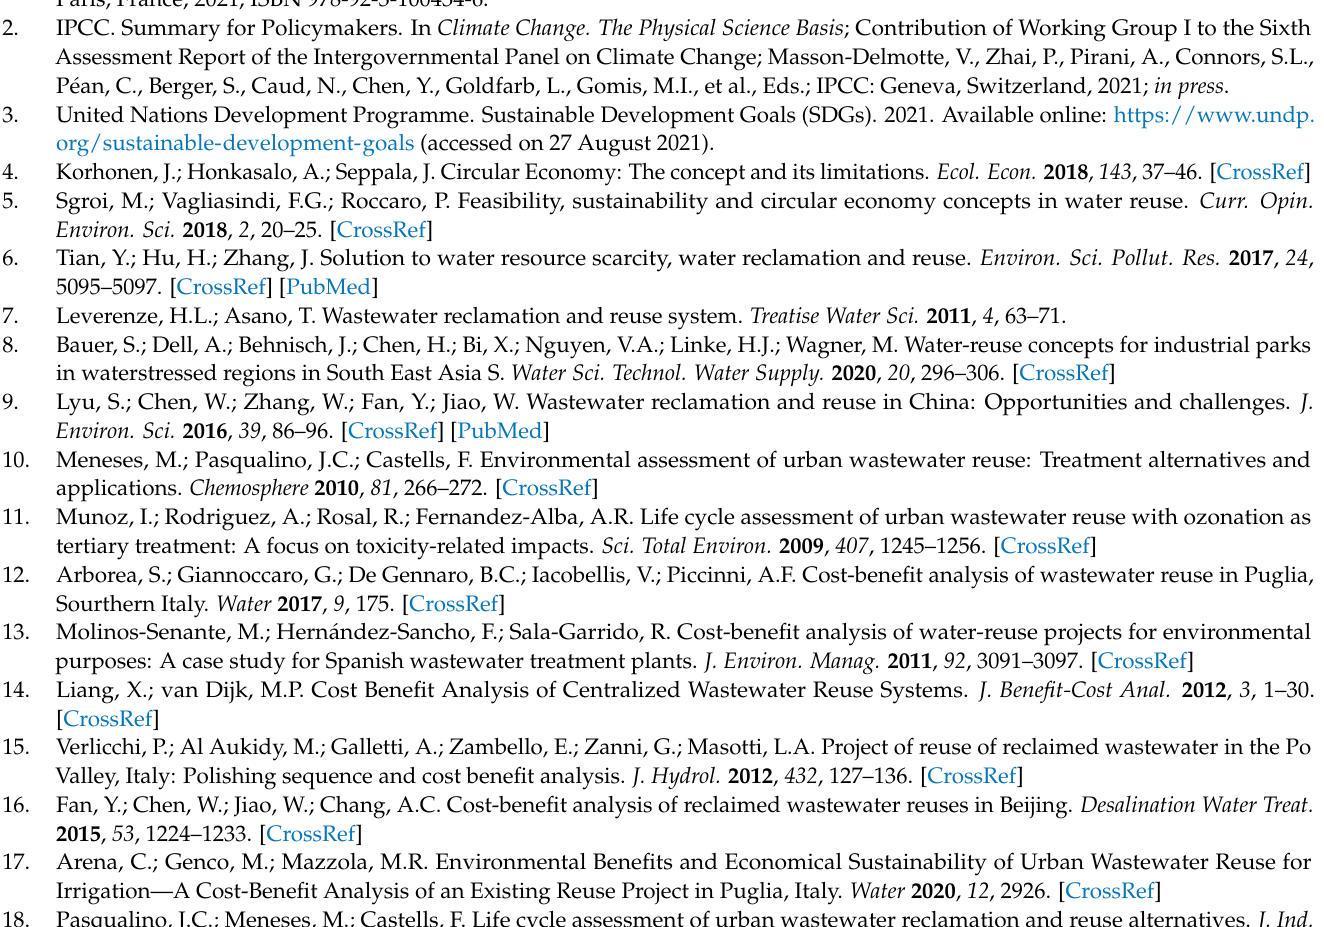
values (NPVs) of water reclamation projects for irrigation of plants and green areas. Table S9: Actual amount of irrigation water in industrial parks in Chonburi in 2018. Table S10: Effective monthly rainfall in Chonburi. Table S11: Irrigation water demand of grass in Chonburi. Table S12: The irrigated green areas based on flow rate scenarios. Text S1: Calculation of irrigation water